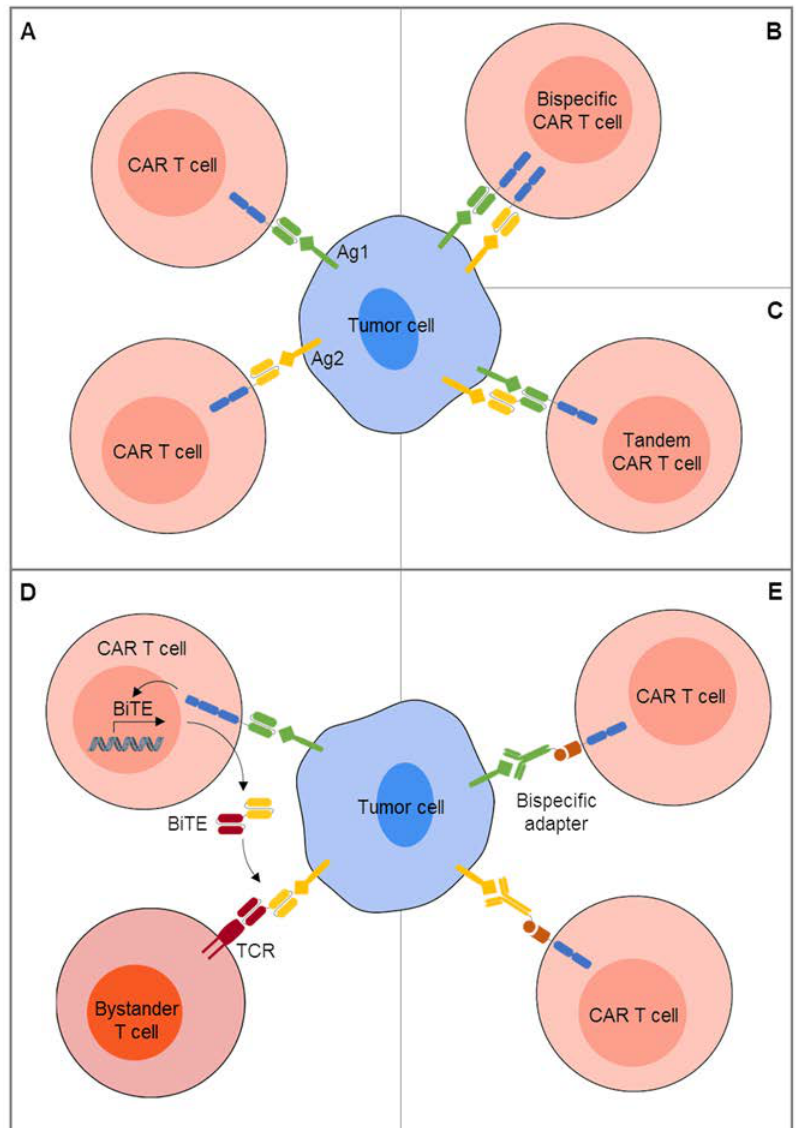
Figure 2. Combinatorial CAR targeting of two or more antigens. ( A ) Two CAR T cell products with individual single antigen specificities are administered simultaneously or sequentially. ( B ) Two CARs with individual single antigen specificities are coexpressed in one T cell. ( C ) Antibody-derived recognition domains for two individual antigens are combined in a single CAR to coengage both antigens. ( D ) CAR T cells are engineered to release a bispecific T cell engager (BiTE) to recruit bystander T cells against a second tumor-associated surface antigen. ( E ) T cells are engineered to express universal CARs with specificity for a molecule not expressed on the surface of any human cells, then bispecific adapters combining this molecule with antibody fragments against individual antigens are added.